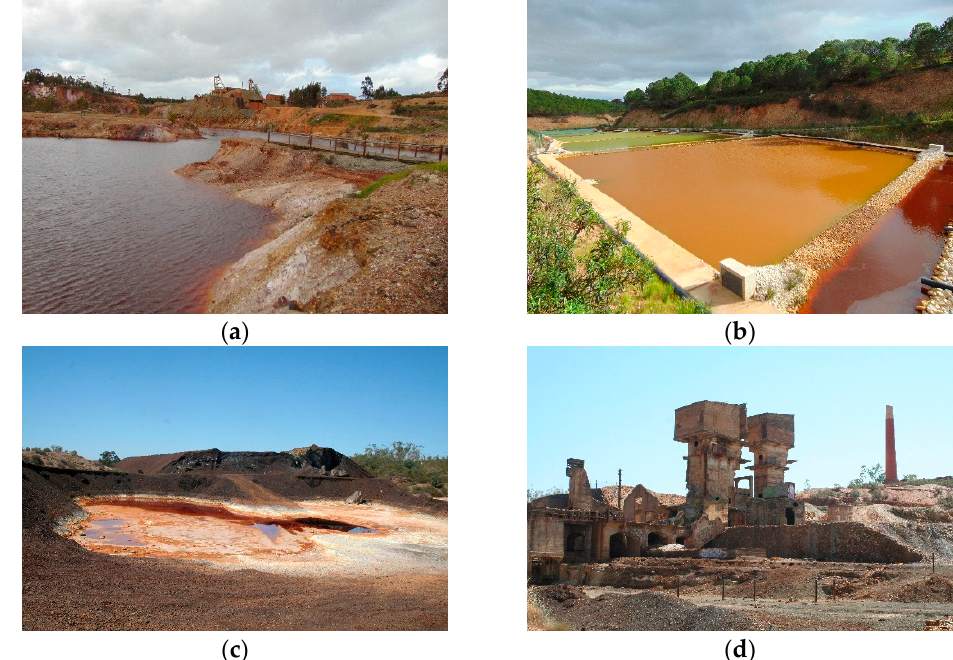
Figure 1. Some aspects of non-active mines of the Portuguese sector of the IPB: ( a ) general view of the Lousal mine, with the tailing deposits in the background of the image; ( b ) the artificial wetland system constructed by EDM to treat the AMD at the Lousal mine (with the different color of the water in the lagoons evidencing the treatment); ( c ) mining wastes deposited in São Domingos, a continuous source of AMD; ( d ) the Achada do Gamo sulfur factory, an emblematic infrastructural feature of the mining exploration at the São Domingos mine (images ( a , b ) courtesy of Cátia Micaelo, December 2016).